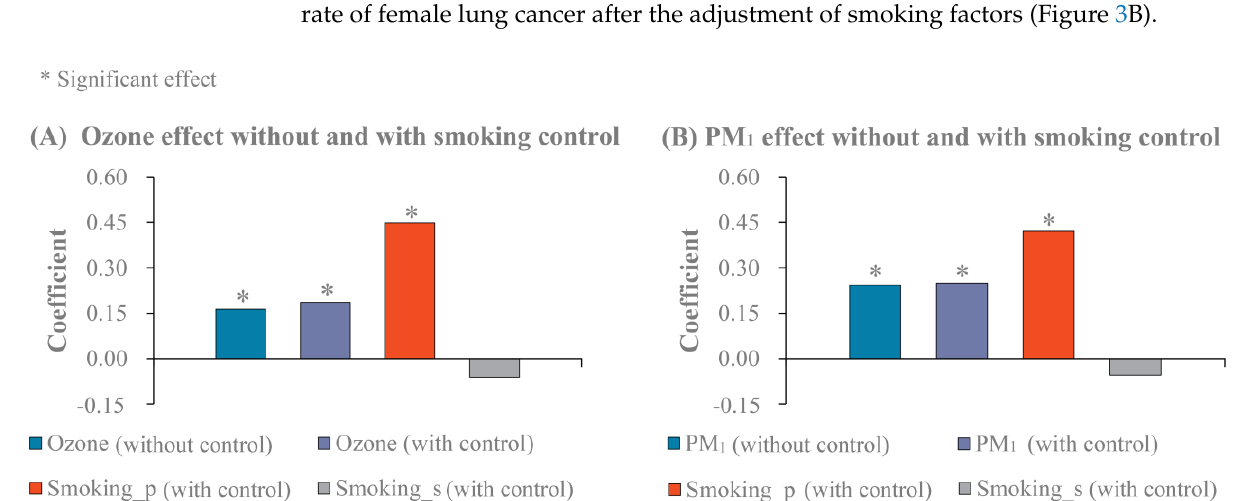
denote smoking prevalence and smoking strength (i.e., the number of cigarettes smoked per day), respectively.